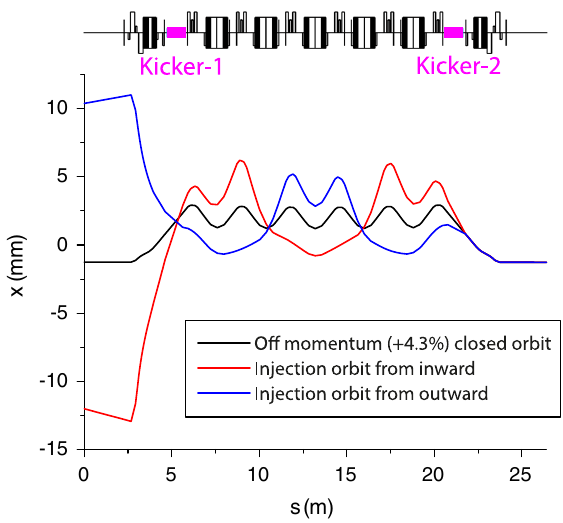
FIG. 5. Fast injection orbit with two short pulse kickers. The kick angle is 1.8 mrad for each kicker. Magenta boxes in the schematic lattice layout indicate the location of the kickers, where a straight section of about 1.3 m is available for each kicker.